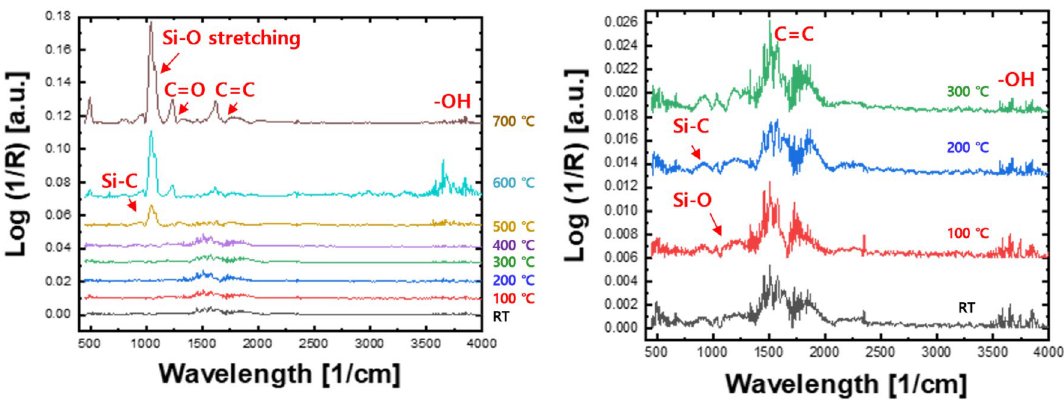
Figure 10. Fourier-transform infrared (FT-IR) spectra of Si/SiC/ta-C composite (Si–ta-C) (3.86 at.% Si) coatings before and after annealing at different